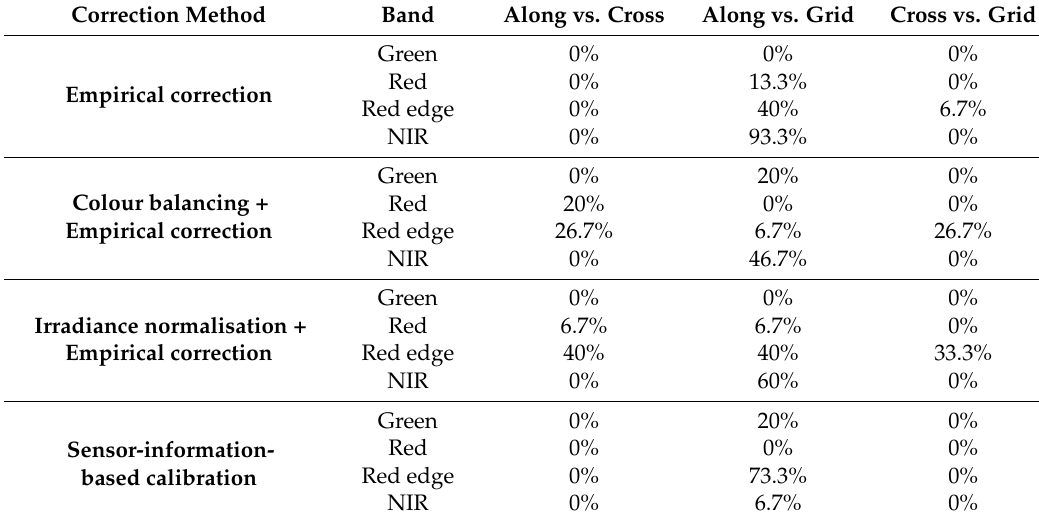
Table A6. Reflectance consistency percentages of ground areas between different flight patterns in dataset 3.